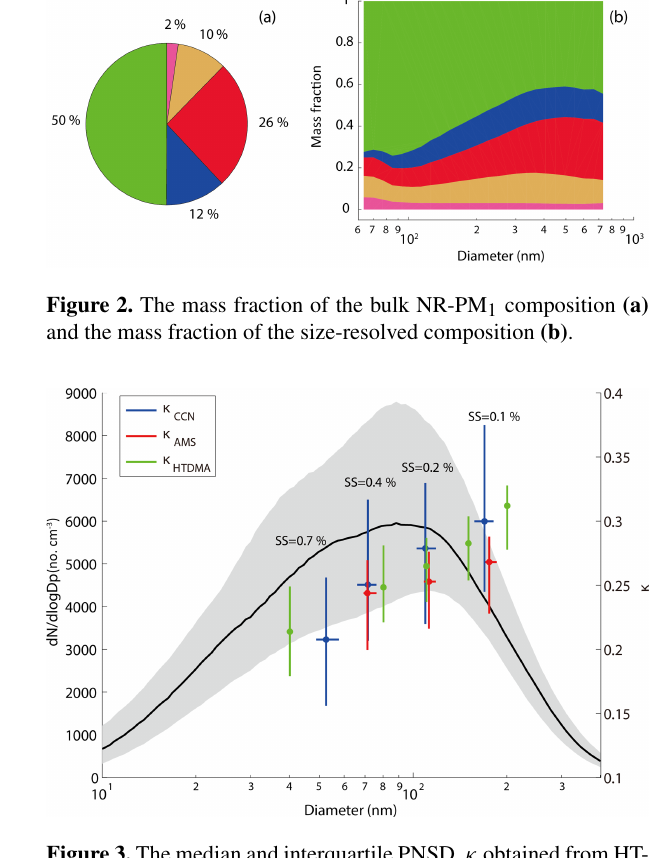
Figure 3. The median and interquartile PNSD, κ obtained from HT- DMA, AMS, and CCN measurements during the campaign. The κ was pointed against their corresponding median D 50 (SMCA and AMS) or measured diameter (HTDMA). Dots represent the median value and the bars represent the interquartile range. The blue, red, and green colors represent κ CCN , κ AMS , and κ HTDMA ,